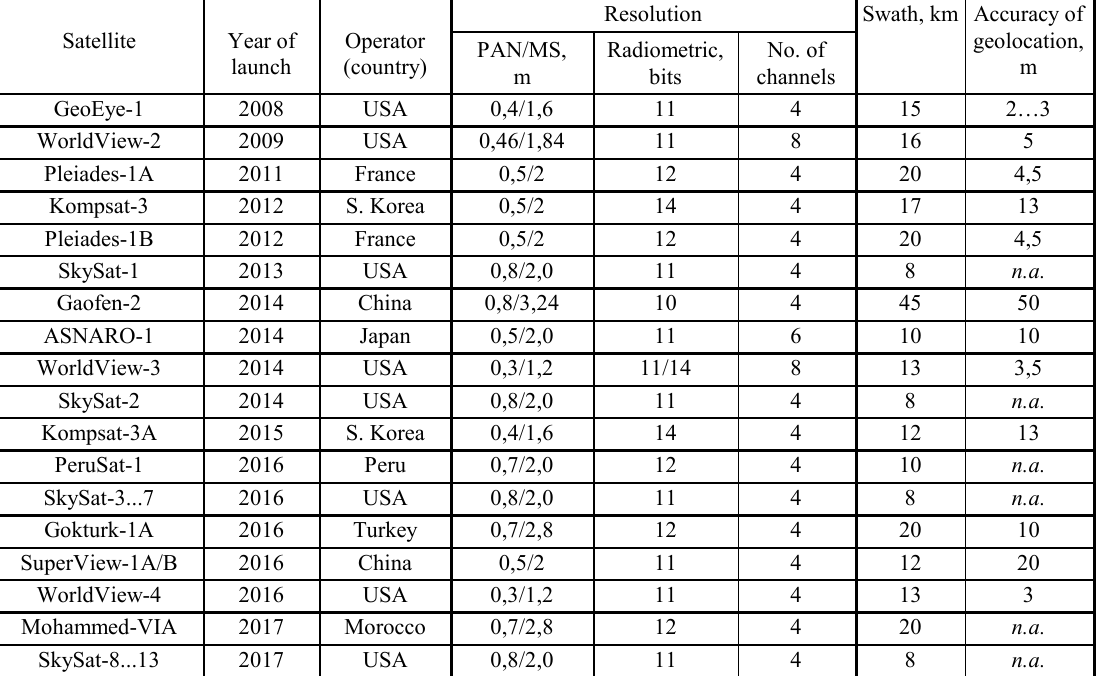
Table 1. Satellites with multispectral scanners of sub-meter resolution